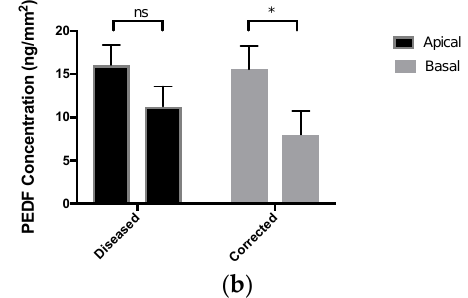
Figure 4. Secretion of PEDF by RPE cells at passage 3 on day 30: ( a ) no significant difference between concentration of PEDF in the apical chamber or basal chamber when comparing diseased and corrected cells; ( b ) significant difference between the apical and basal chambers for corrected cells indicating establishment of apicobasal polarity. ns equals not significant, N = 3, * p <